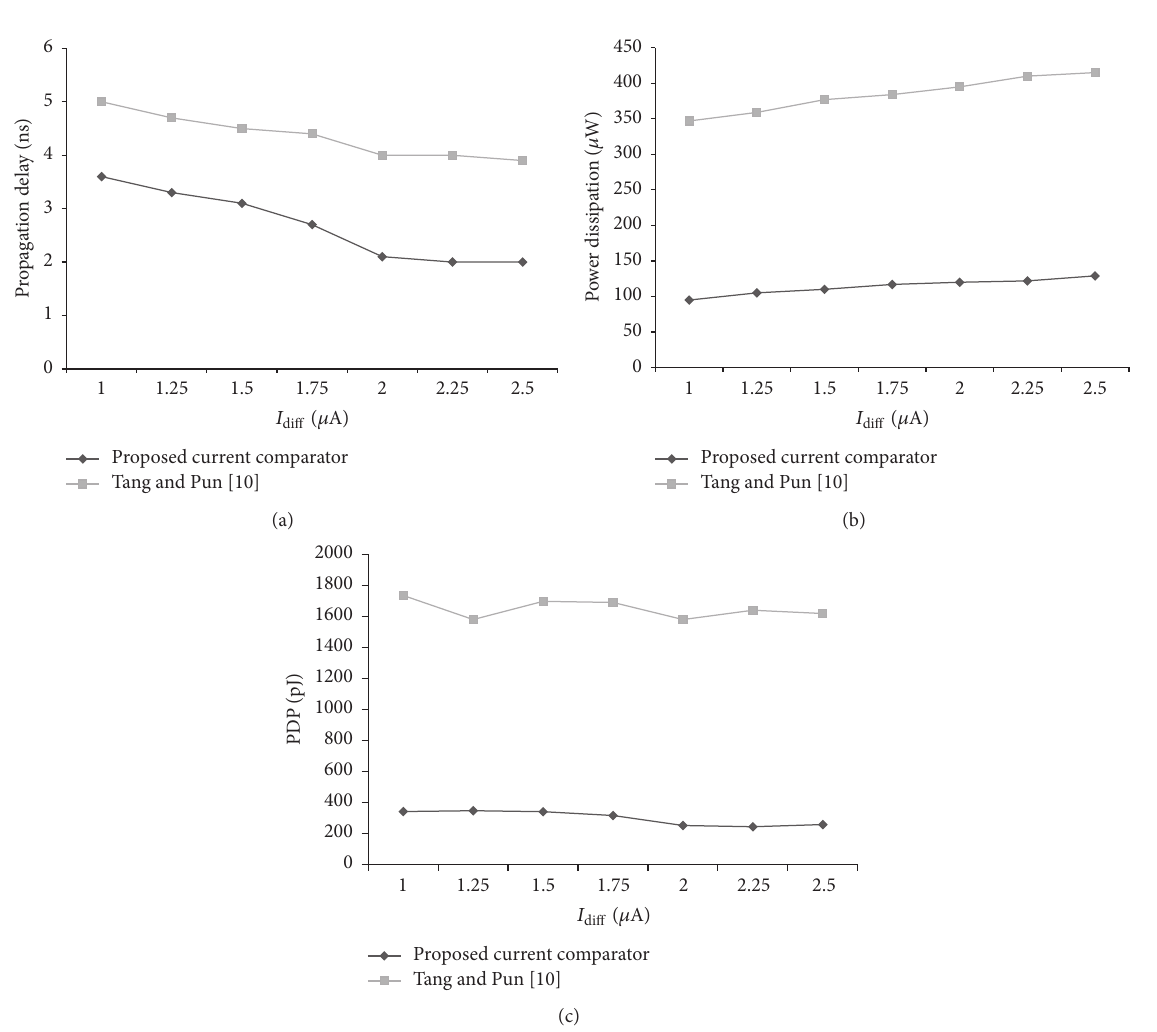
transitions should actually take place. The INL is calculated from Figure 11(a) and a maximum INL of − 0.25 LSB is obtained, as plotted in Figure